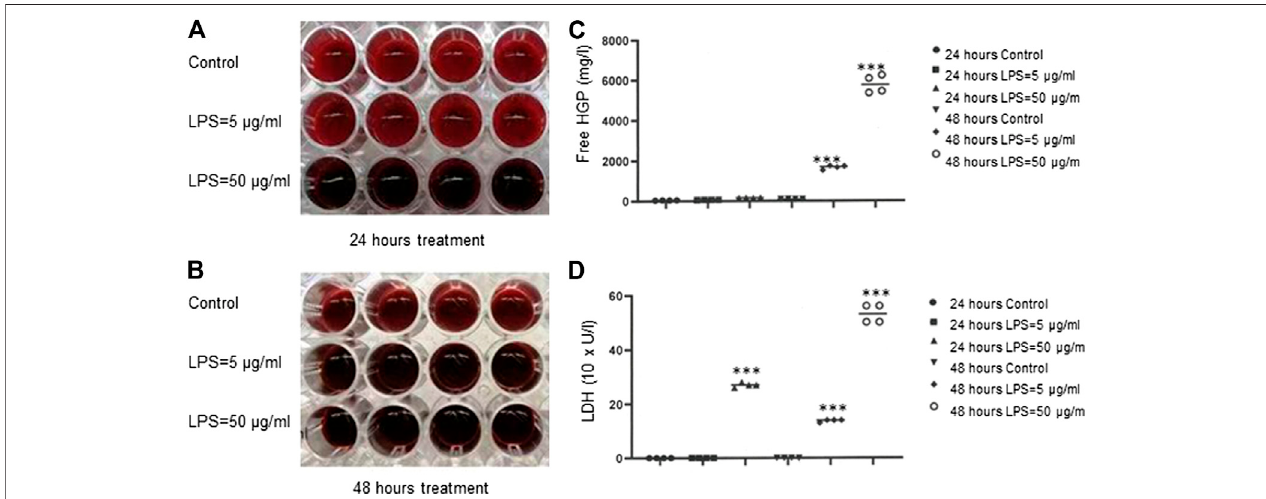
FIGURE 1 | Hemolysis induced by bacteria LPS. (A – B) Detection of LPS-induced RBCs lysis indicated by dark red color. (C) Free HGP content after exposure of RBCstoLPSat5or50 μ g/mlfor48 h (D) LDHactivityafterexposureofRBCstoLPSat50 μ g/mlfor24 horat5or50 μ g/mlfor48 h*** p < 0.001 vs. control.Datawere representative of four blood